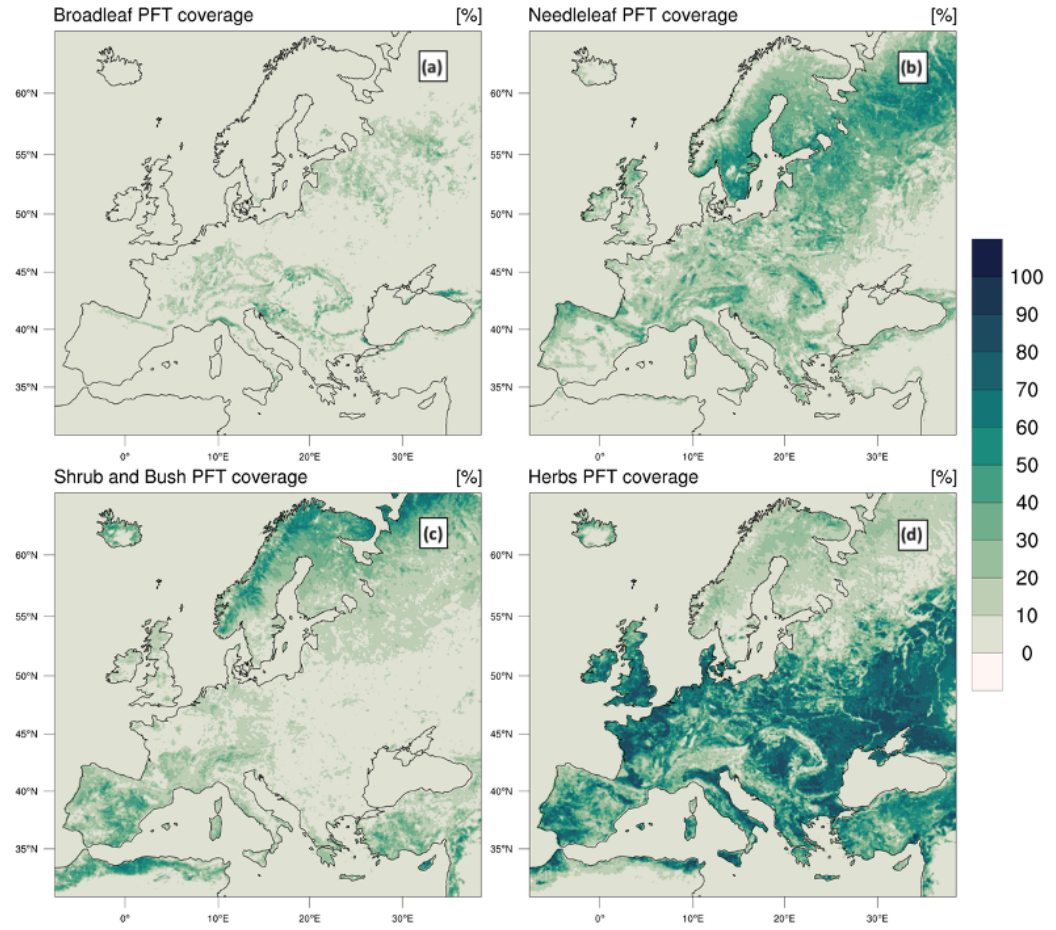
Figure 6. Percentage coverage (%) of plant functional type (PFT) classification included in the MEGAN database, computed in August 2015. From the upper left map: (a) coverage of broadleaf trees (PFTP_HB), (b) needleleaf trees (PFTP_NB), broadleaf shrubs (PFTP_SB), and (d) grass and other